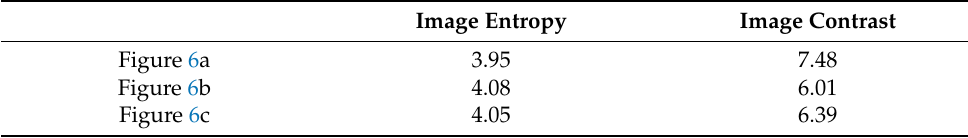
Figure 6. ISAR images of antenna A obtained by ( a ) the proposed method; ( b ) the method in [25] by taking Q as the reference scatterer; ( c ) the method in [25] by taking the target center as the reference scatterer. Table 2. Comparison of image entropy and contrast.